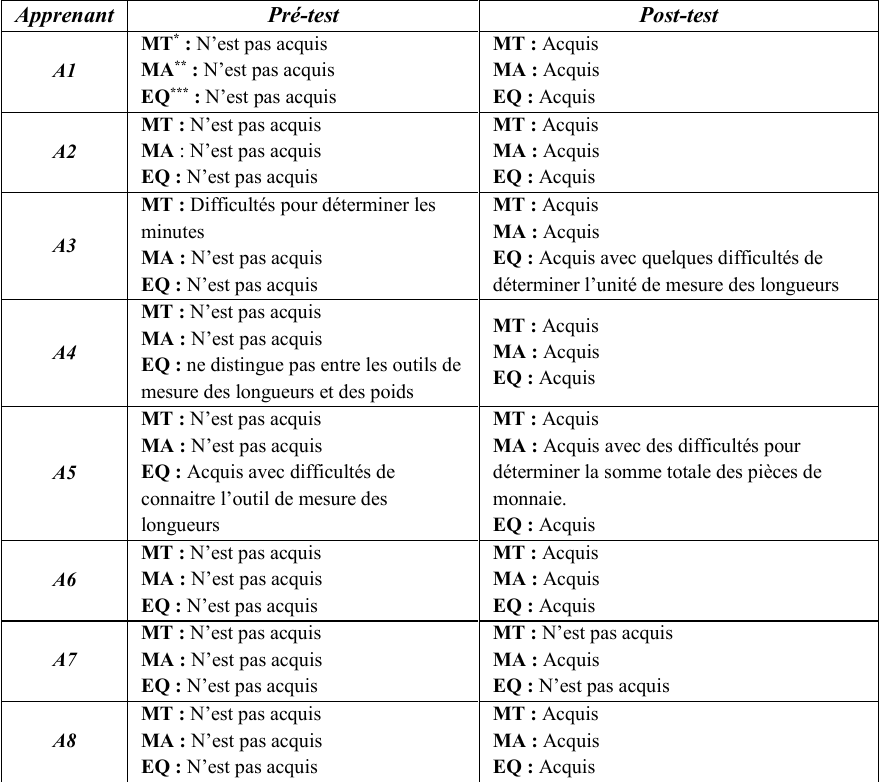
Tableau 6 : Les résultats du pré et du post-test de l’échantillon expérimental ( MT : Lire le temps ; MA : Manipuler l’argent dans des situations de la vie quotidienne ; EQ : Utiliser les outils et les unités de mesure des poids et des